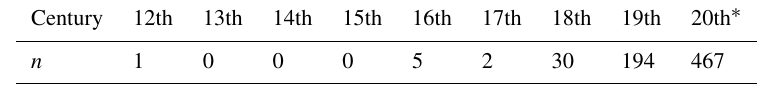
Table 3. The number of landslide records within centuries in Czechia between the twelfth and twentieth centuries.